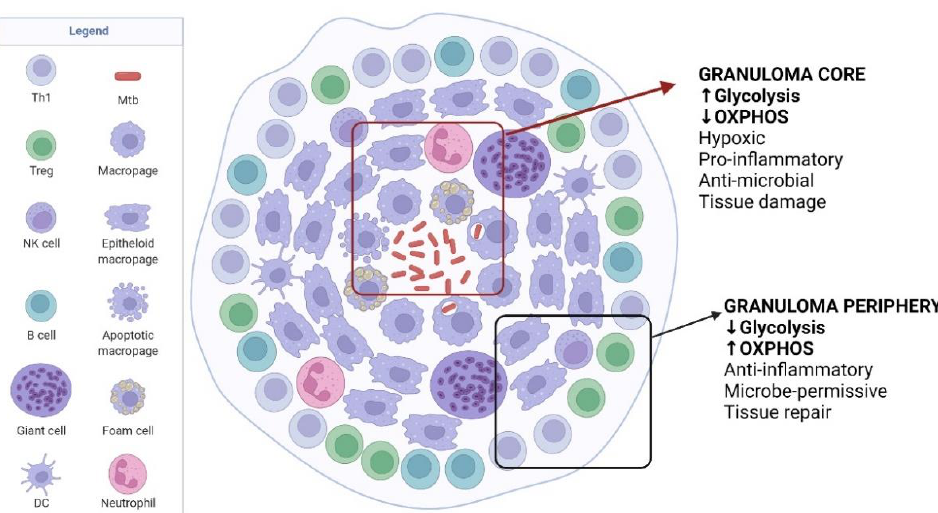
Figure 2. TB immunometabolism in the granuloma. Granuloma develops as TB disease progresses, which contains Mtb but also helps Mtb to persist in the host. The core of granuloma is highly hypoxic and inflammatory, mainly maintained by glycolysis, to kill Mtb but causes damage to host tissues. Moving to the granuloma periphery, the environment becomes less inflammatory with increased tissue repair functions but favourable to Mtb survival. Adapted from “Granuloma”, by BioRender.com (2022). Retrieved from https://app.biorender.com/biorender-templates, accessed